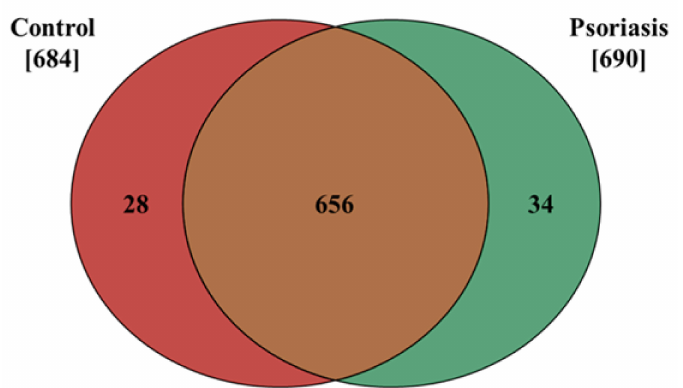
Figure 1. Venn diagram showing the number of proteins in fibroblasts isolated from the skin of psoriatic patients ( n = 5) and healthy controls ( n = 5). The names and ID of all the proteins identified are contained in the Supplementary Table S1.